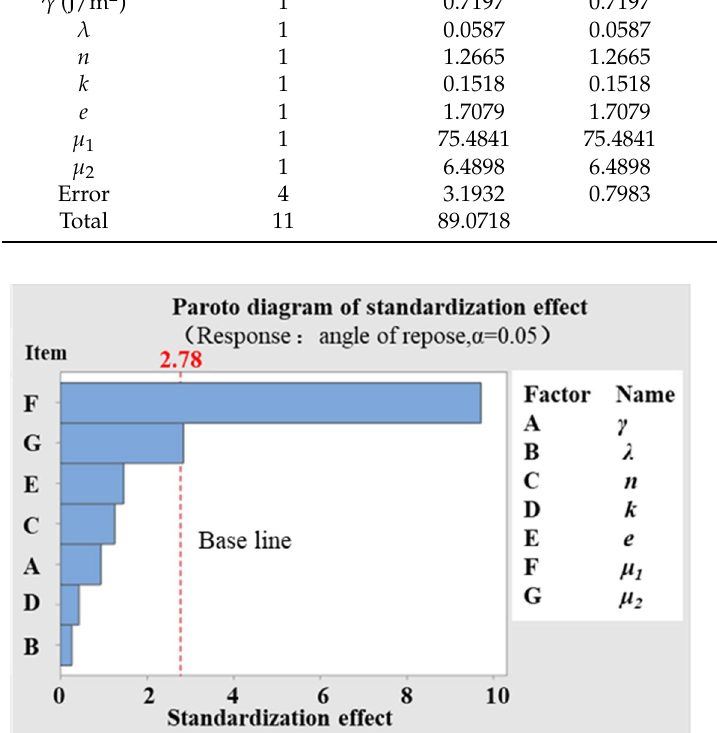
Figure 5. Pareto diagram of the standardization effect of PB test.